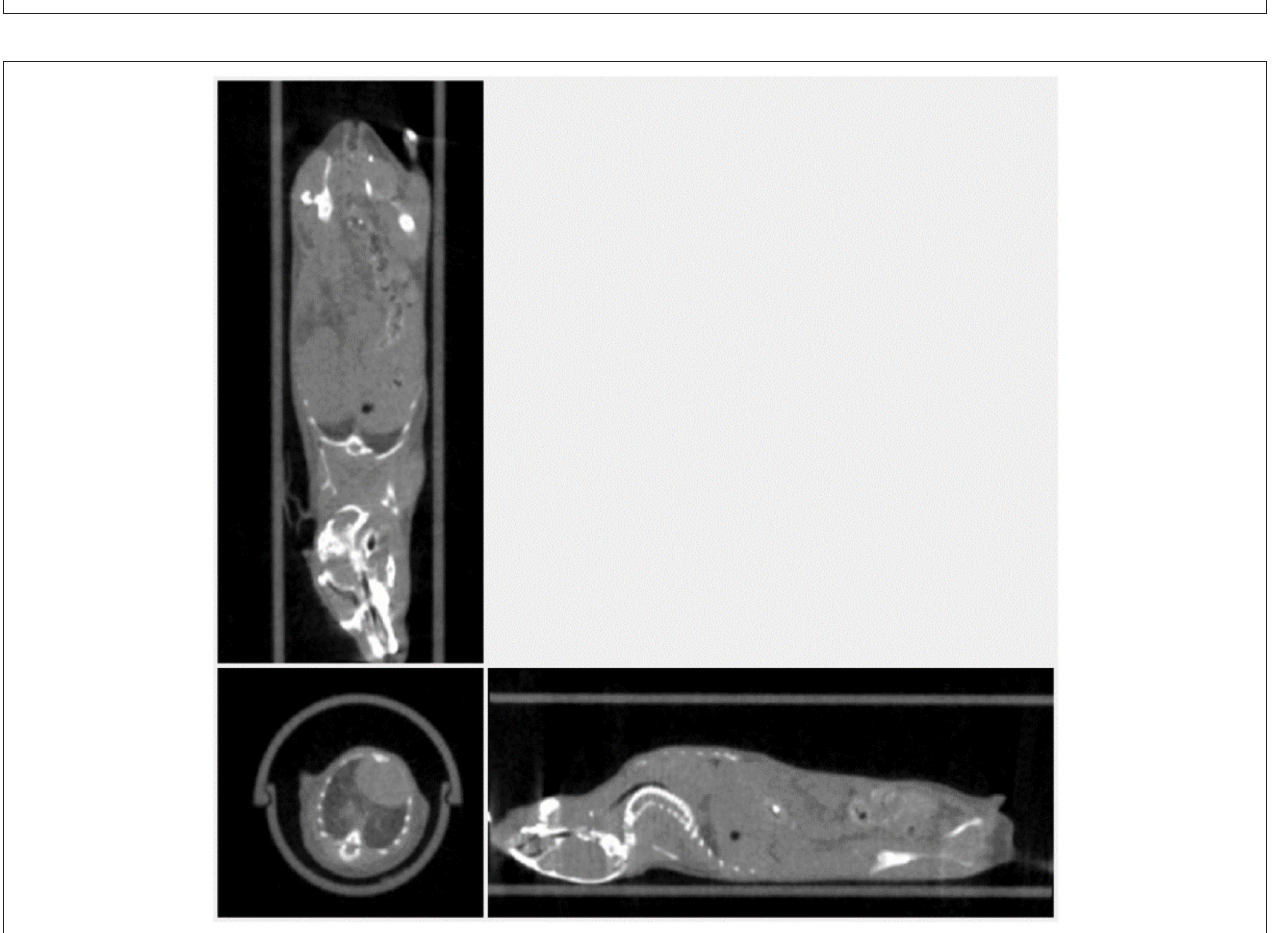
FIGURE 14 | Mouse imaged with 54 kVp, 900 µ A, and an acquisition time of 7s and dose < 10 mGy. The image voxel is 200 um.